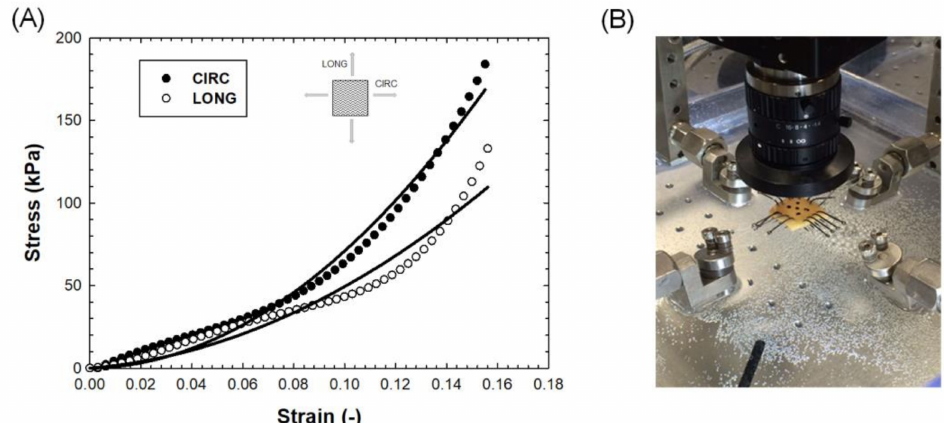
Figure 3. ( A ) Experimental stress–strain data (dots) and fitting (solid lines) from biaxial testing; ( B ) photography of experimental setup.